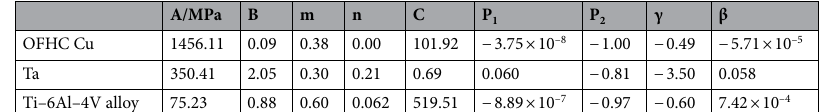
Table 1. Material parameters for the present constitutive model.